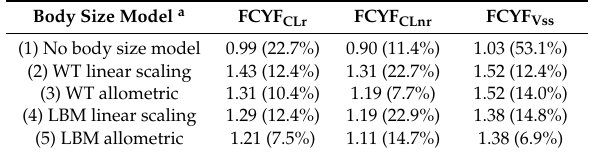
Table 3. Disease factors representing the group estimate in patients with CF divided by the group estimate in healthy volunteers for the respective clearance or volume of distribution parameters.